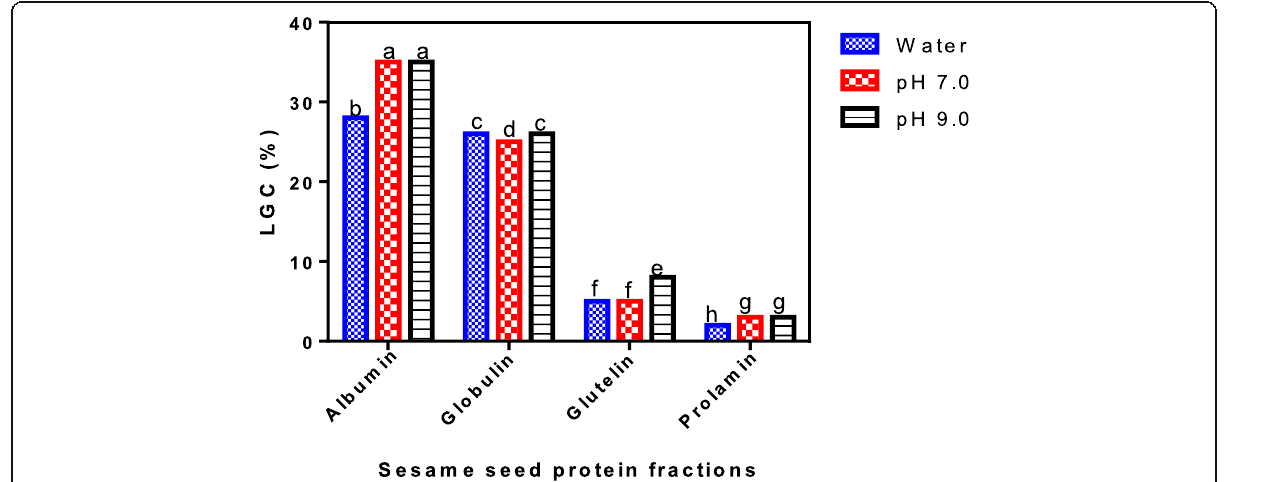
Fig. 7 Gelation concentration of sesame protein